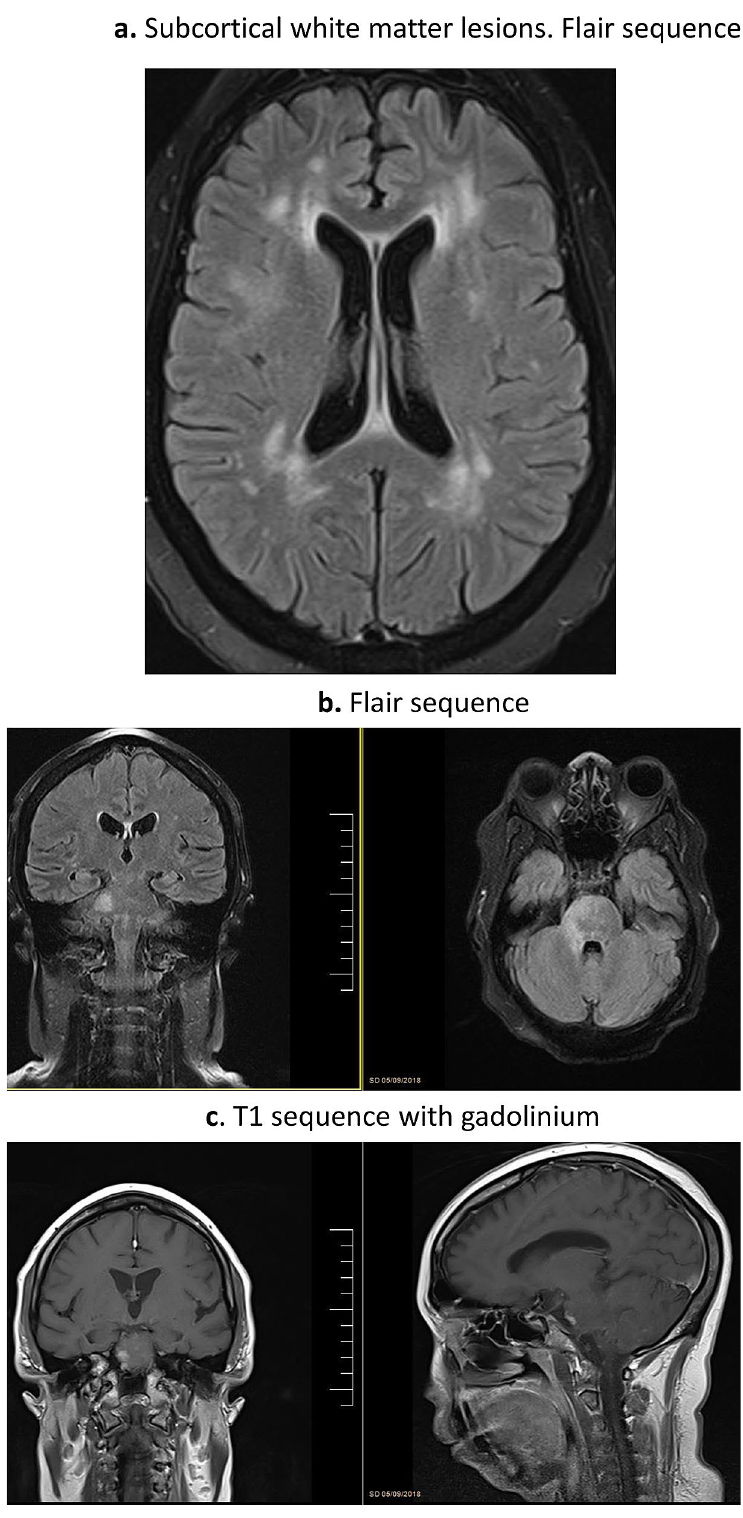
Figure 1. Intraparenchymal lesions. Pontine right lateral lesion that enhances with gadolinium: ( a ) Flair sequence and ( b ) T1 sequence with gadolinium; ( c ) Subcortical white matter lesions, Flair